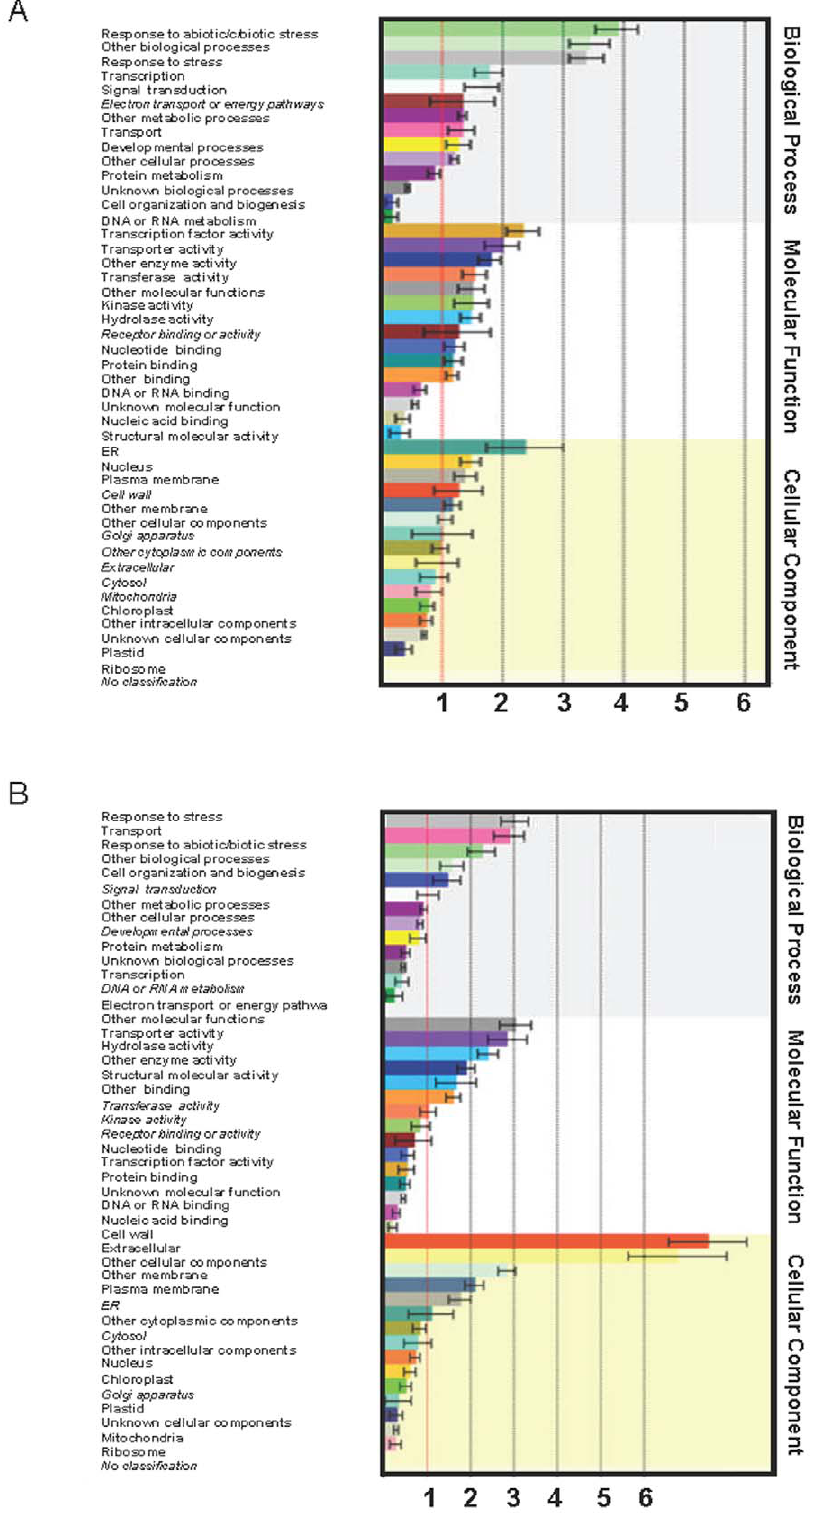
Figure 1. Functional annotations of genes regulated by dicamba treatment. Functional classification of genes regulated by dicamba based on the Gene Ontology (GO) database using the Arabidopsis Classification SuperViewer [29], A, Genes induced B, Genes repressed. Four day old seedlings were collected 10 hours after a 7 mM dicamba treatment for the array, with 3 biological replicates. All genes included in the tables had fold change $ 3 and an adjusted p # 0.05. The values are a normed frequency, which is calculated as follows: (Number_in_Class input_set / Number_Classified input_set )/(Number_in_Class reference_set /Number_Classified reference_set ) (error bars = bootstrap StdDev). Genes with a p-value of the hypergeometric distribution . 0.5 are in italics. Full records of differentially expressed genes are listed in Tables S1 and S2.